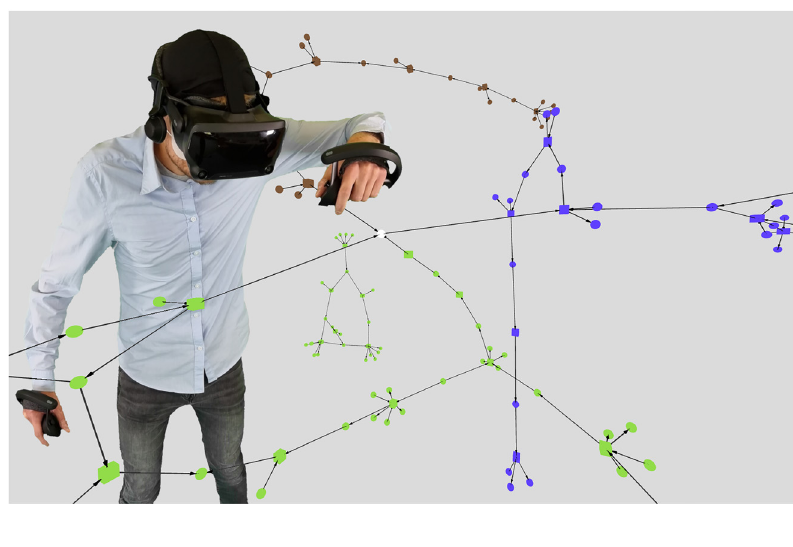
Figure4: A3Dvirtualrealityrep- resentation using A-Frame. The same pathways are shown as in the detail view in Figure 3, using the same colour